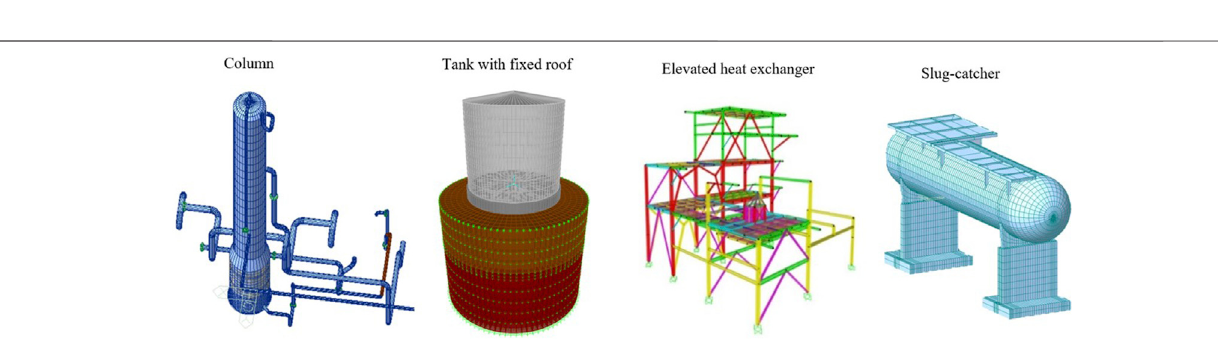
FIGURE 9 | Examples of fi nite element models of the main equipment.